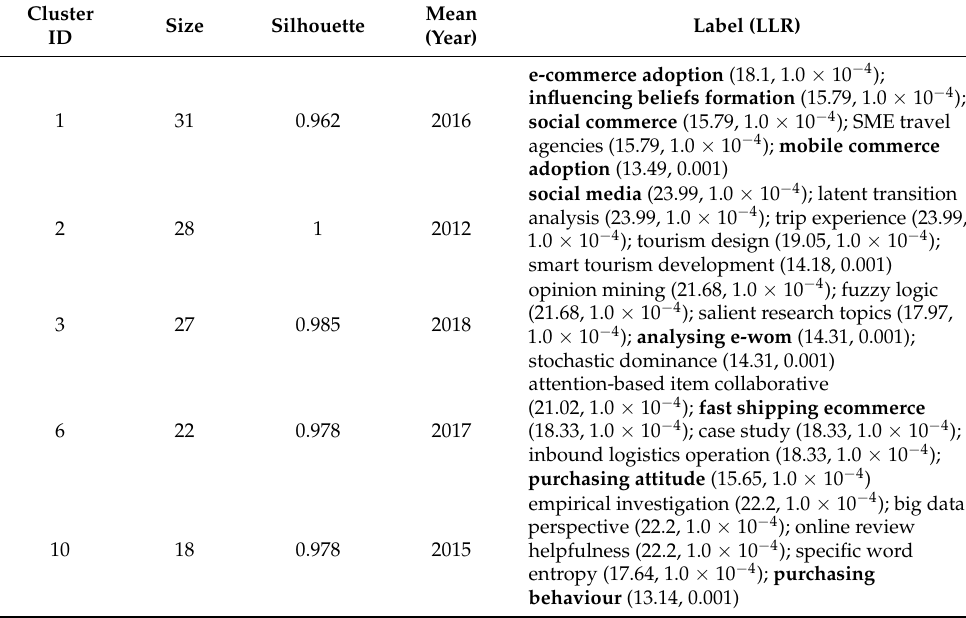
Table 3. Top terms by cluster labels and indicators for electronic commerce.